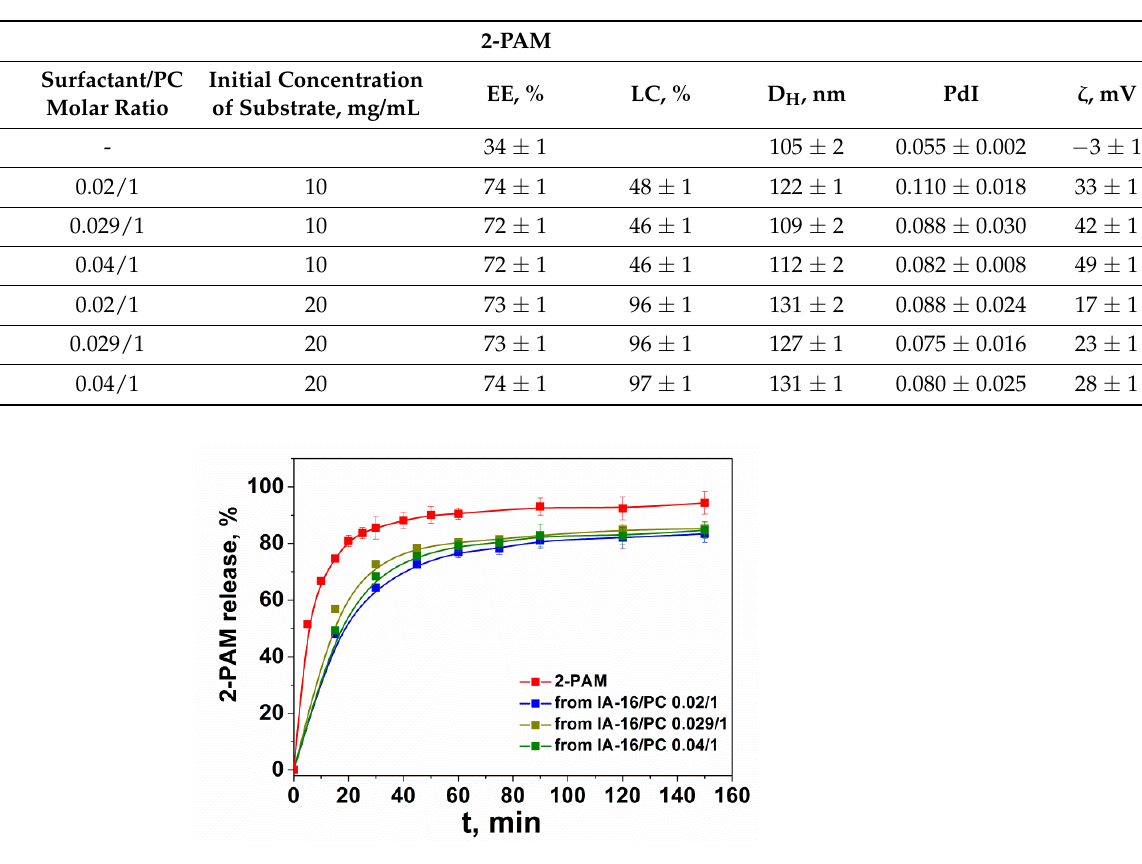
Table 3. Physicochemical characteristics of liposomes based on PC modified by IA-16 loaded with 2-PAM at various surfactant/lipid molar ratios and different loadings of the substrate: encapsulation efficiency (EE, %), loading capacity (LC, %); hydrodynamic diameter (D H , nm), polydispersity index (PdI), and zeta potential ( ζ , mV), 25 ◦ C.